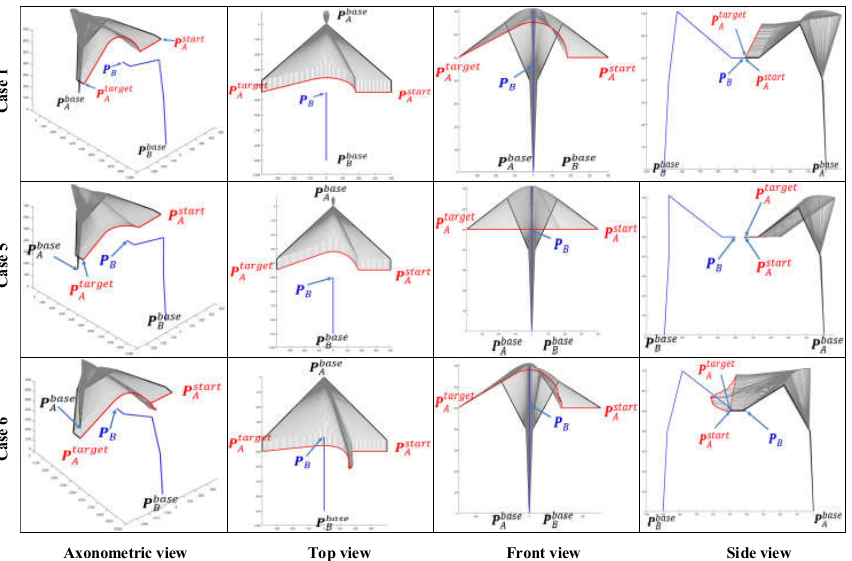
Figure 8. Comparison of single manipulator avoidance simulation results for three initial path cases. B.